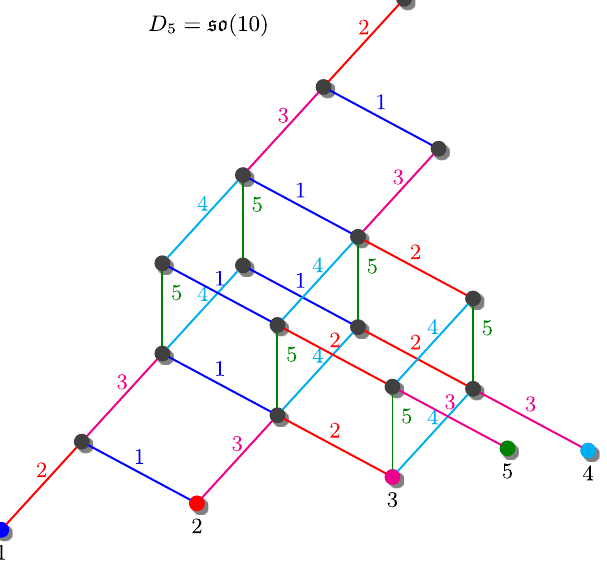
( so ð 10 Þ ) . FIG. 6. Hasse diagram for the positive root lattice Δ þ There are 20 roots in total (black dots), arranged into 7 levels. The lattice extends into three dimensions as the simple root α 3 has connectivity 3. To find the α pattern corresponding to a simple root α , one begins at α and also collects the nodes by always i i proceeding forward in the direction of the highest root. The Z 2 automorphism of the Dynkin graph reveals itself as the reflection symmetry with respect to the main diagonal of the cube passing though nodes 4 and